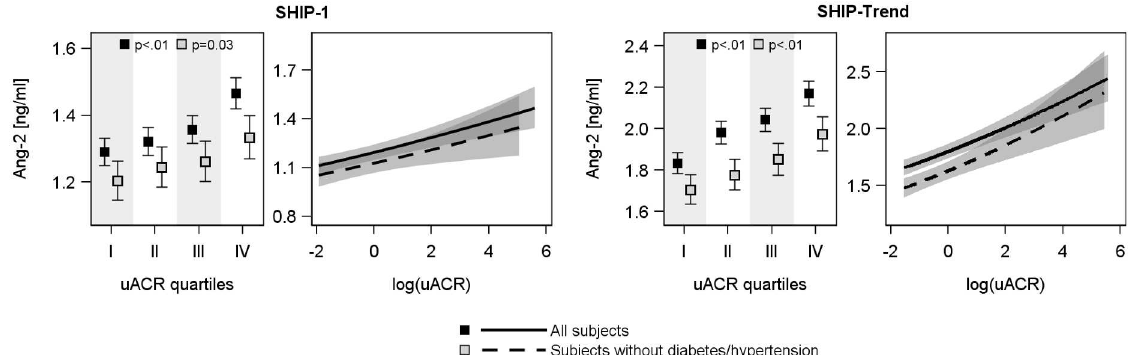
Fig 4. Associations between urinary albumin-to-creatinine ratio (uACR) and serum angiopoietin-2 concentration in SHIP- 1 (left side) and SHIP-Trend (right side). For each study populationleft side: Estimated mean serum Ang-2 with 95% confidence intervalsby sex-specificquartilesof uACR calculatedby analysisof variance adjustedfor age, sex and waist circumference. Right side: linear regression line with 95% confidenceintervals (grey shadedarea). Linearregressionmodels with restricted cubic splines were adjustedfor age, sex, waist circumference, smoking, total cholesterol, systolic and diastolicblood pressure and additionally in the wholepopulationfor diabetesmellitus type 2 and use of antihypertensive medication.